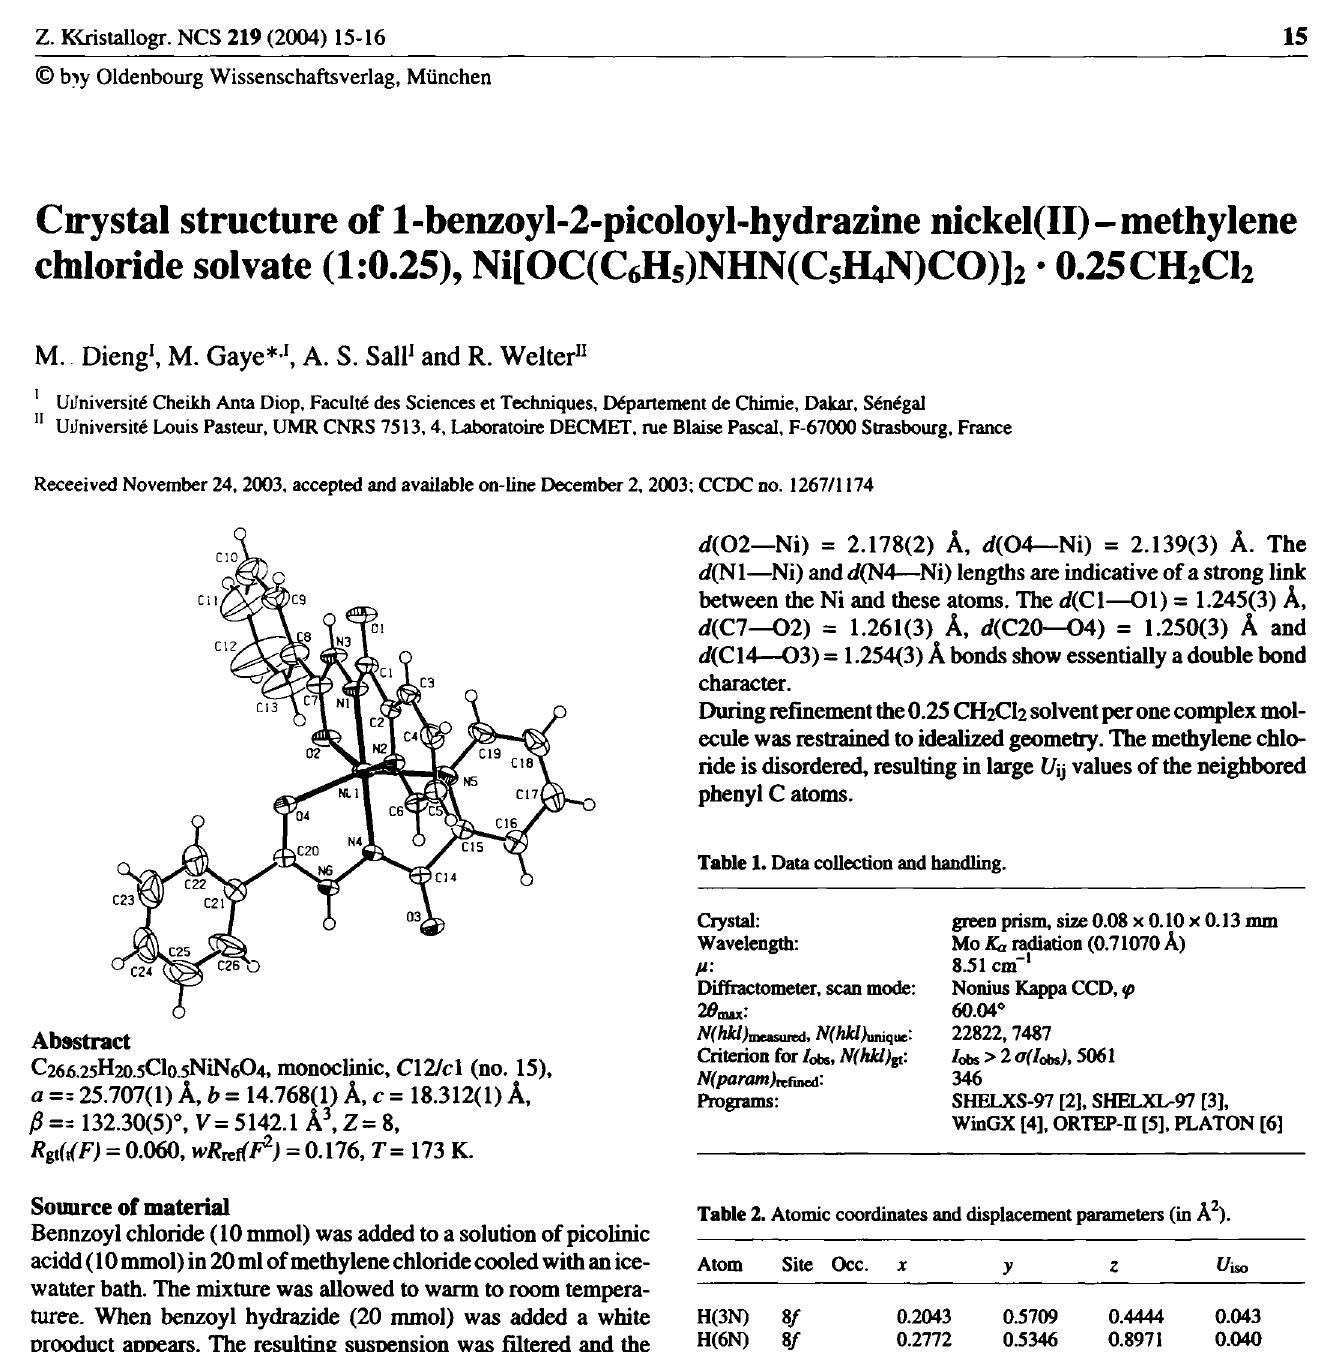
Table 2. Atomic coordinates and displacement parameters (in Â 2